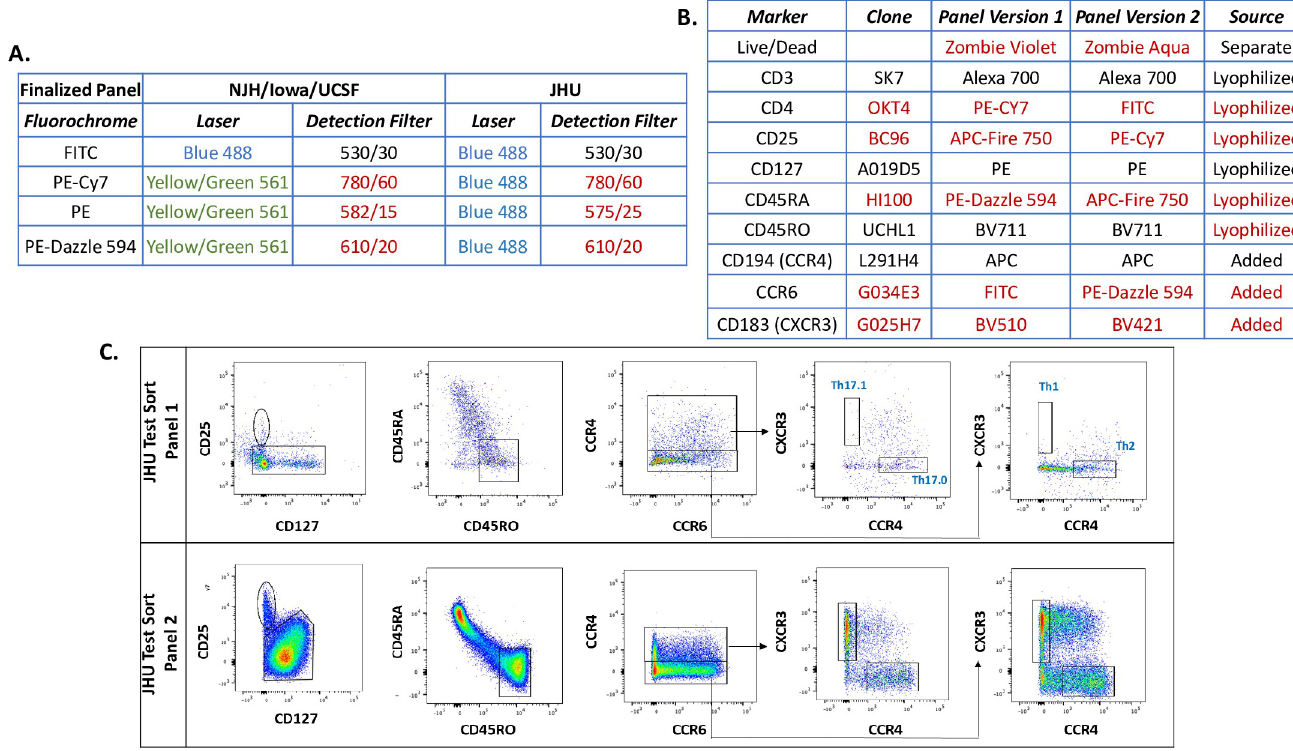
Fig 3. Testing of flow panels for optimal resolution of T cell subset identification due to variations in cytometer specifications between different study sites. A) Differences in cytometer laser/filter set combinations by site for the finalized panel. Red text denotes lasers/filters that differ between sites. B) Two variations of the flow panel that were tested to optimize population separation based on differences between cytometers, noting which reagents were in the lyophilized antibody cocktail, added to the antibody cocktail, or stained separately. Red text indicates fluorochromes that differ between the two panels. C) Side by side comparison of T cell subset identification by panel 1 or